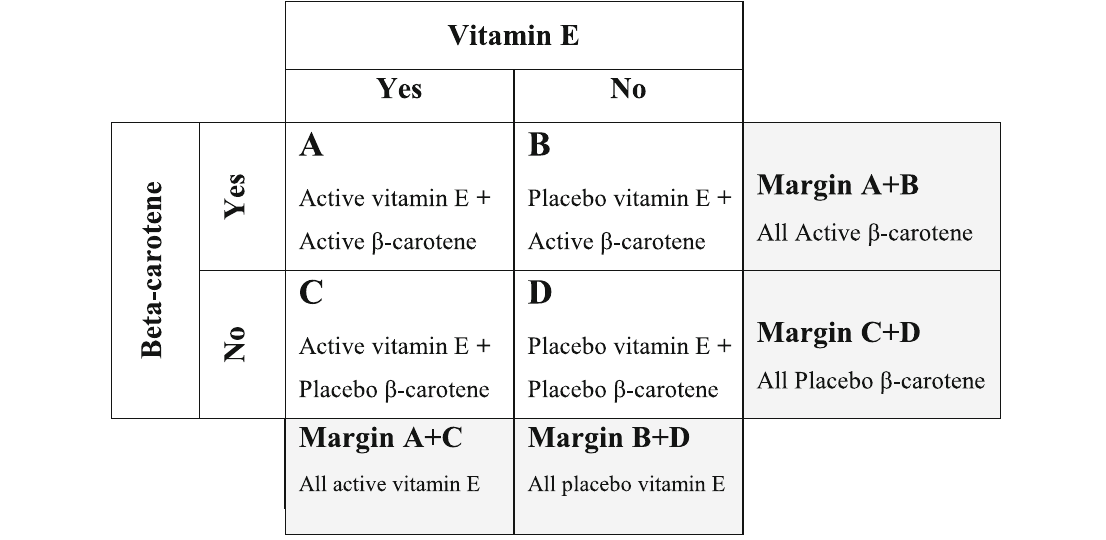
Legend: A simple factorial design (2 × 2) has 4 separate treatment arms represented by the 4 cells inside the Table (A, B, C and D). In the ATBC study [7] the four treatments were: cell A - active vitamin E with active β -carotene; cell B - active β -carotene with placebo vitamin E; cell C - active vitamin E with placebo β - carotene; and cell D - placebo vitamin E with placebo β -carotene. An ‘ inside the table ’ analysis uses two cells and compares active vitamin E alone (cell C) to all placebo (cell D) or compares active vitamin E alone (cell C) to active β -carotene alone (cell B); an ‘ at the margins ’ analysis uses 4 cells and compares all active vitamin E against and all placebo vitamin E (margin cell A + C vs margin cell B + D). The analysis used in the Cochrane review [3] uses 3 cells and compares all active vitamin E (margin cell A + C) to placebo (cell D)